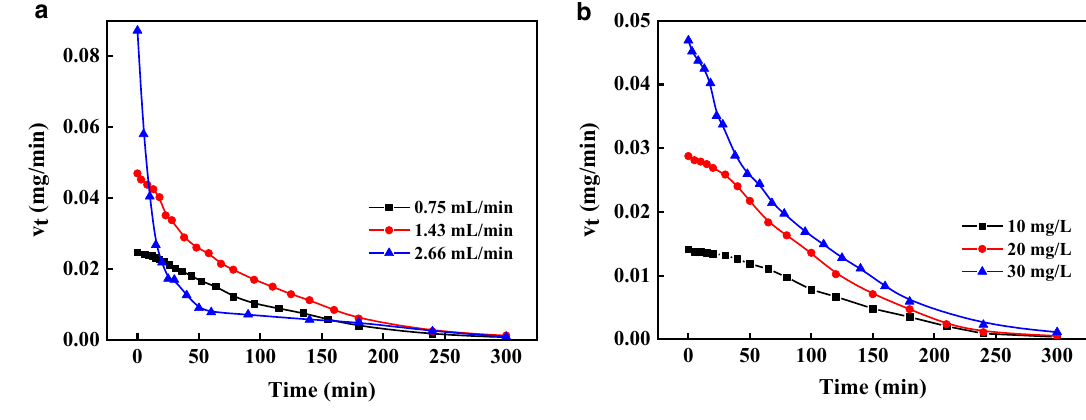
Fig. 12 The calculated Vt as function of t at different feed flow rates ( a ) and Pb2 + initial concentration ( b ) Table 6 The dynamic Conditions Trans-membrane flow adsorption capacity per unit area (Q d ) calculated using the data in Fig. 12